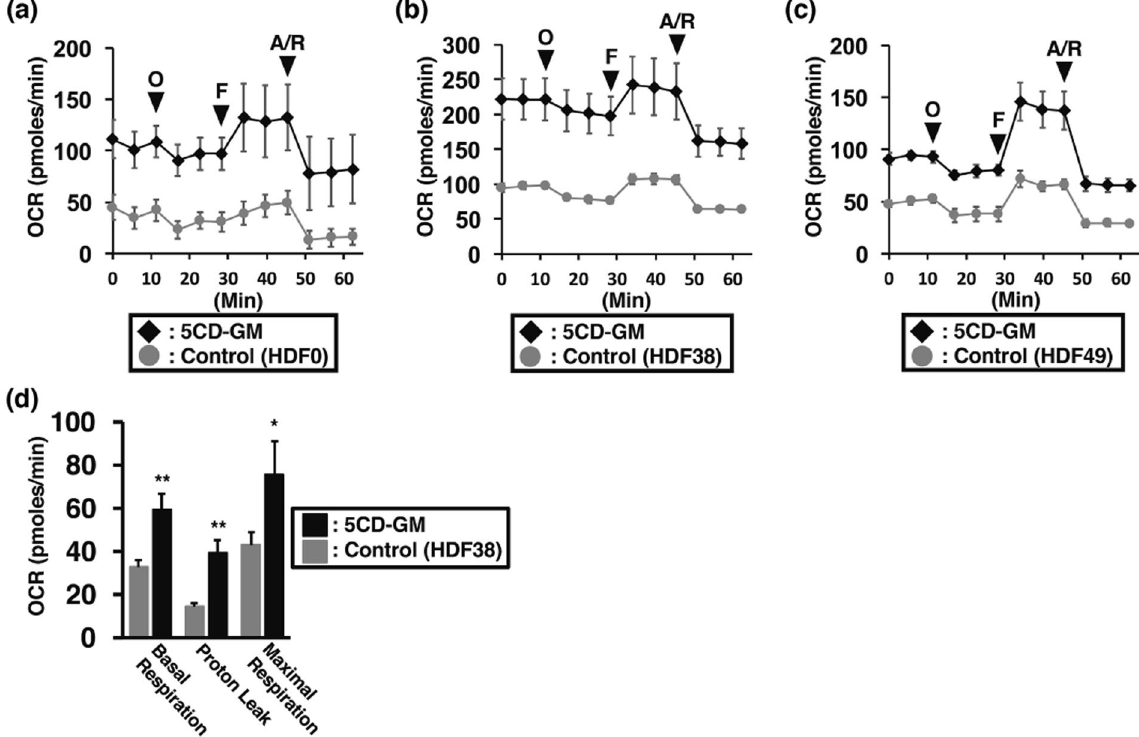
Figure 5. Increased oxygen consumption rate (OCR) in ciBAs. OCR was measured using the Flux analyzer in the control cells (the adipocyte medium only, grey circles) and ciBAs (black diamonds) derived from the 3 lines of human fibroblasts, HDF0 ( a , n = 5), HDF38 ( b , n = 3), and HDF49 ( c , n = 4). Oligomycin (O), FCCP (F), and Antimycin A/Rotenone (A/R) were added at indicated times to final concentrations at 2, 0.25, and 0.5 μ M, respectively. ( d ) The OCR for basal respiration, proton leak, and maximal respiration was compared between the control and ciBAs derived from HDF38 fibroblasts (n = 3). Data represent mean ± SD. Student’s t-test: * P < 0.05, ** P <